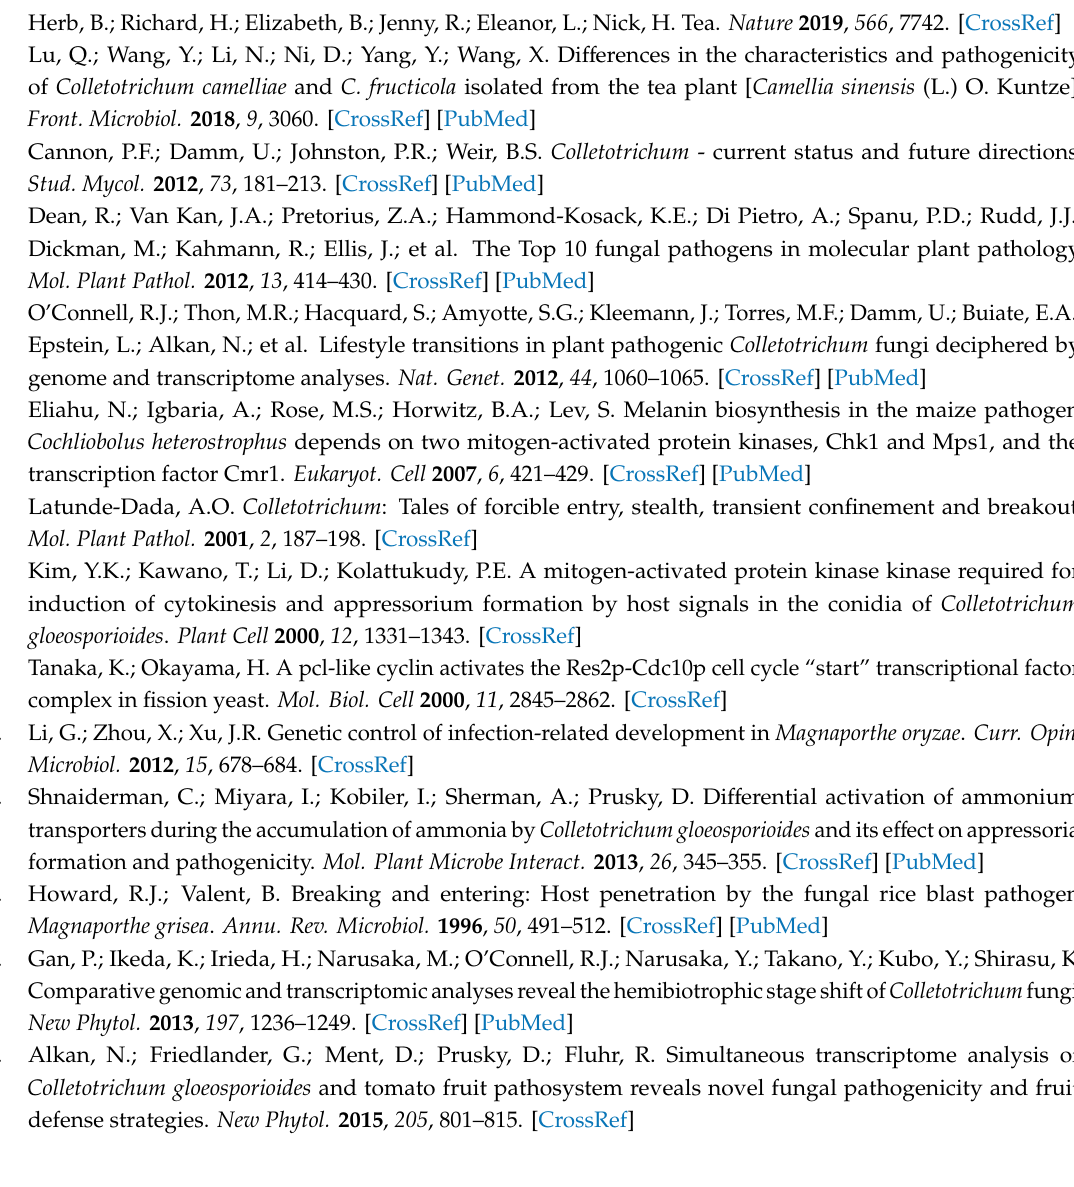
group, Table S7: The genes information of KEGG analysis based on whole DEGs between four comparison groups, Table S8: The genes information of KEGG analysis of specific up-DEGs of GT, CIH, IL compare to App, Table S9: The FPKM value of genes that relevant to melanin biosynthesis, Table S10: The FPKM value of genes that relevant to cAMP and MAPK signaling pathway, Table S11: The FPKM value of genes that relevant to CAZys, Table: S12: The FPKM value of genes that relevant to candidate e ff ector proteins, Table S13: The sequence information of six candidate CEPs. Note: Bold italics are signal peptides